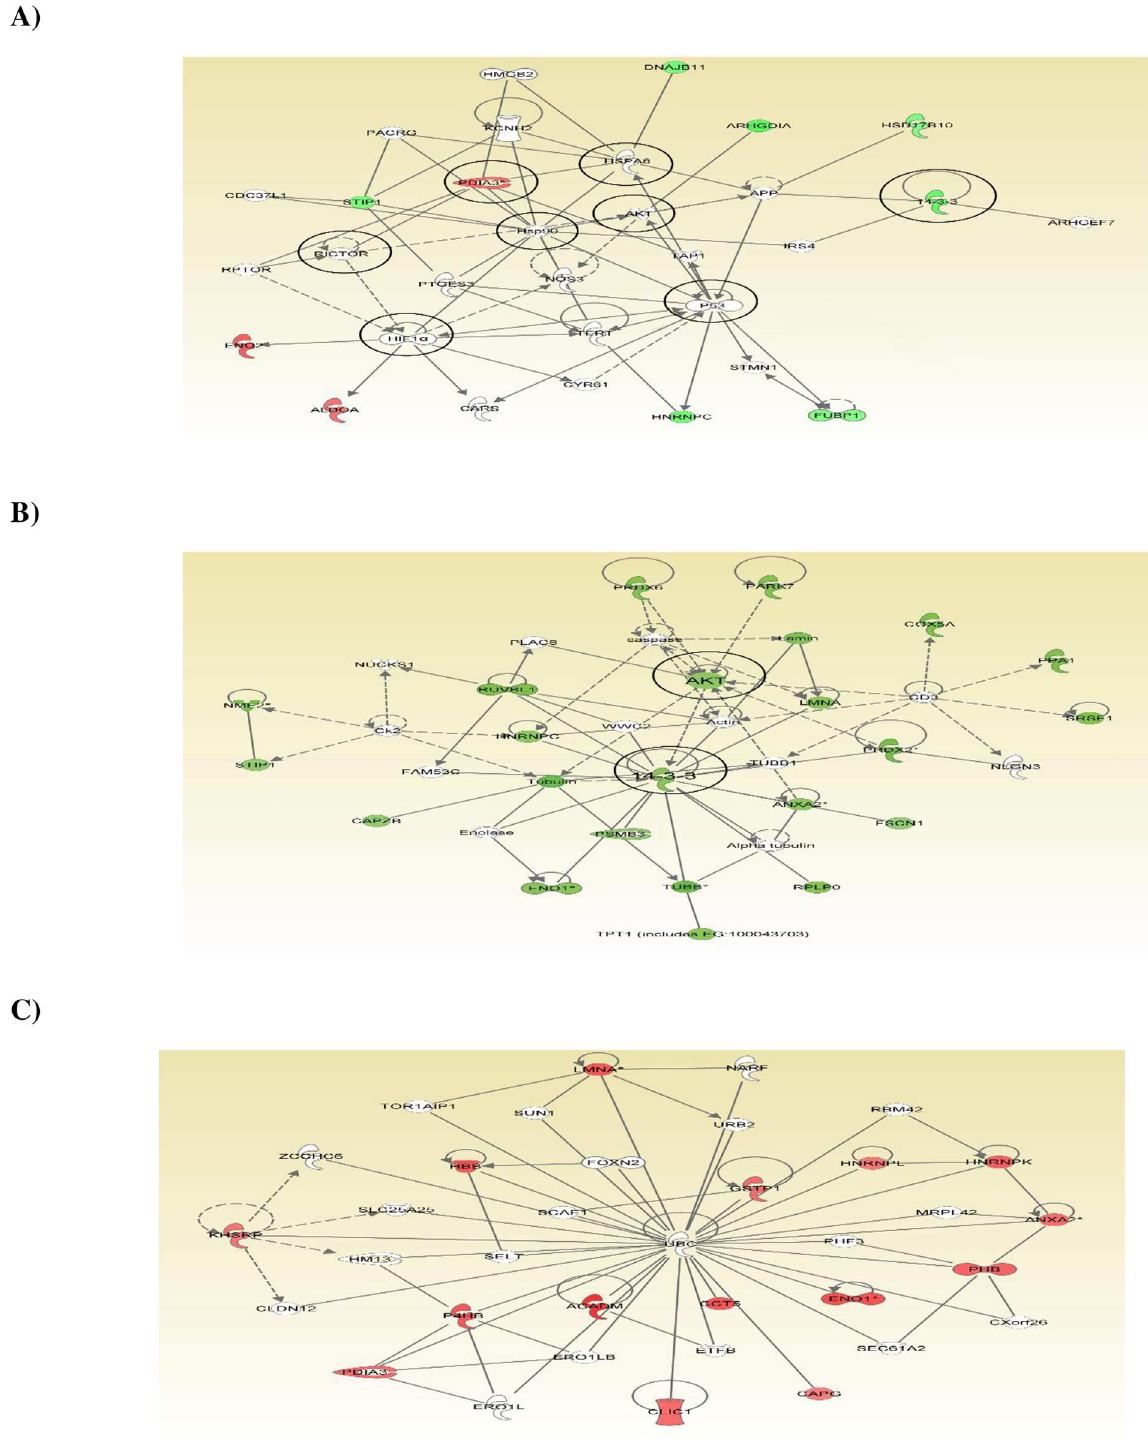
Fig 5. Networksof proteinsshowinginter-relationshipsand pathwayswhich was obtainedusingIPA. A) A sub-network of some differentially expressed proteinsidentifiedfromBEAS-2B cells treatedwith 100 μ M of Ni (II).Greenfields indicatedown- regulationand the red fields indicateup-regulation of the differentially expressed proteins.B) Networkof the proteinsalteredat multipleconcentrations that were down-regulated.C) Networkof the proteinsalteredat multipleconcentrations that were up- regulated.For proteinnetworkor pathways analysis, statisticalsignificance was determined with Fisher’s exact test (p < 0.05).